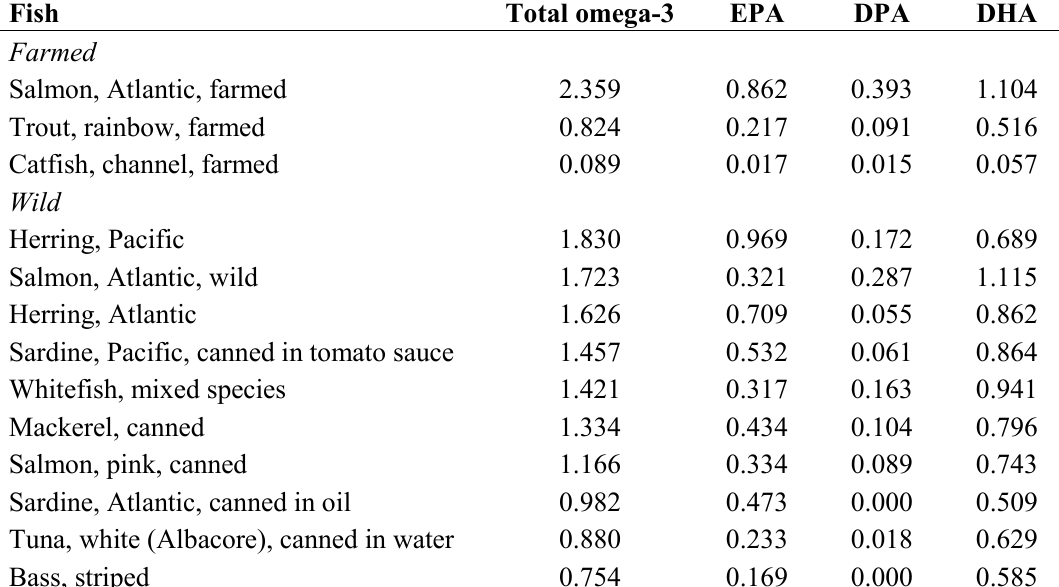
Table 2. Omega-3 content of fish and seafood (g/100 g)